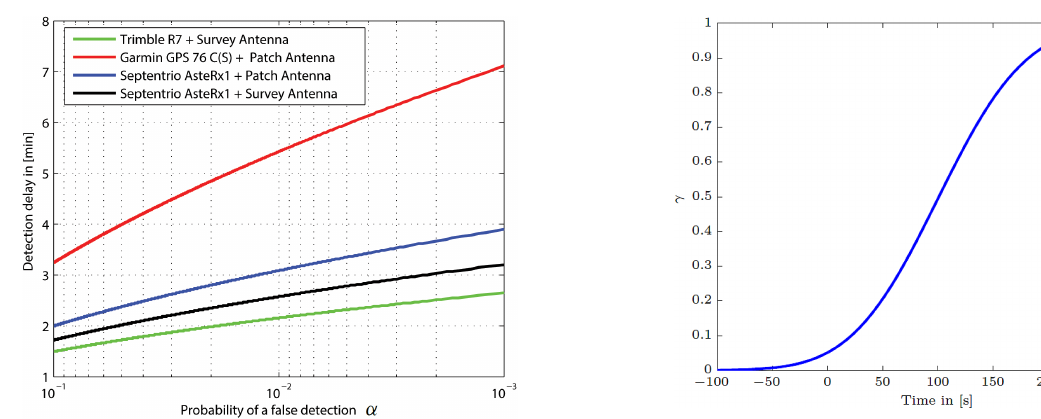
Figure 9. This graph shows the detection delay as a function of the significance level, for various GPS receivers and operation modes. A small value for α indicates a higher significance and a smaller chance on a false alarm. However, a smaller value for α results in a larger detection delay.